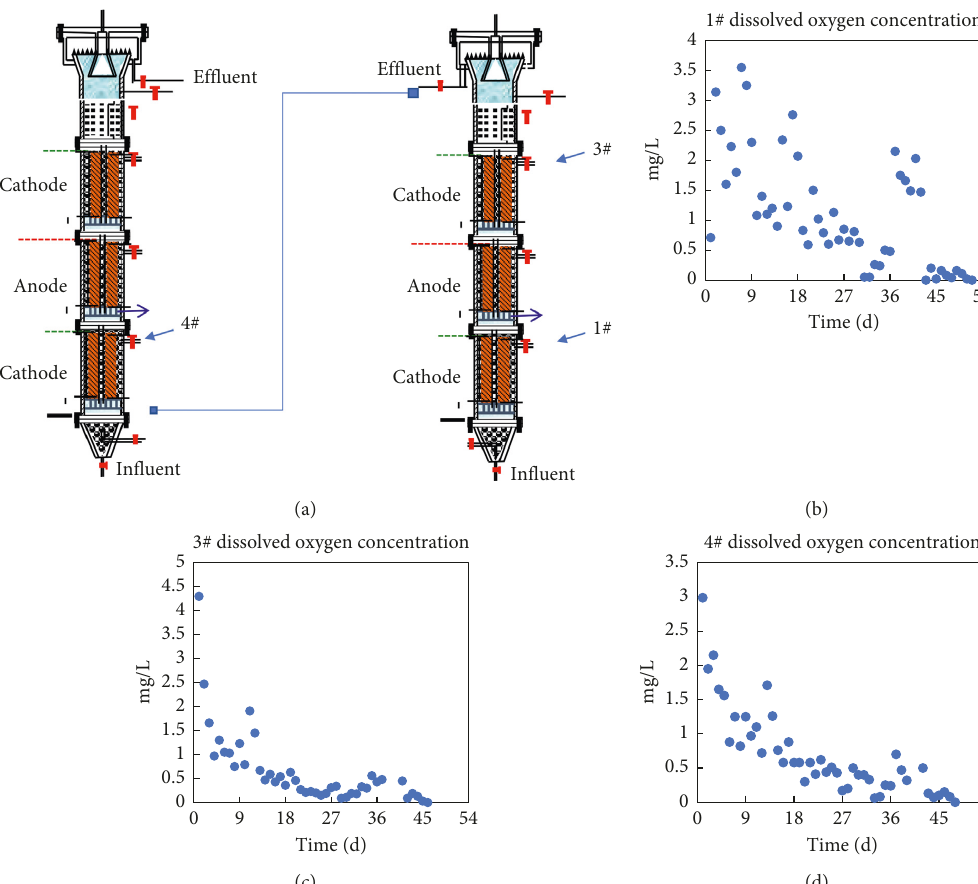
Figure 6: Reactor oxygenation and dissolved oxygen concentration at different effluent